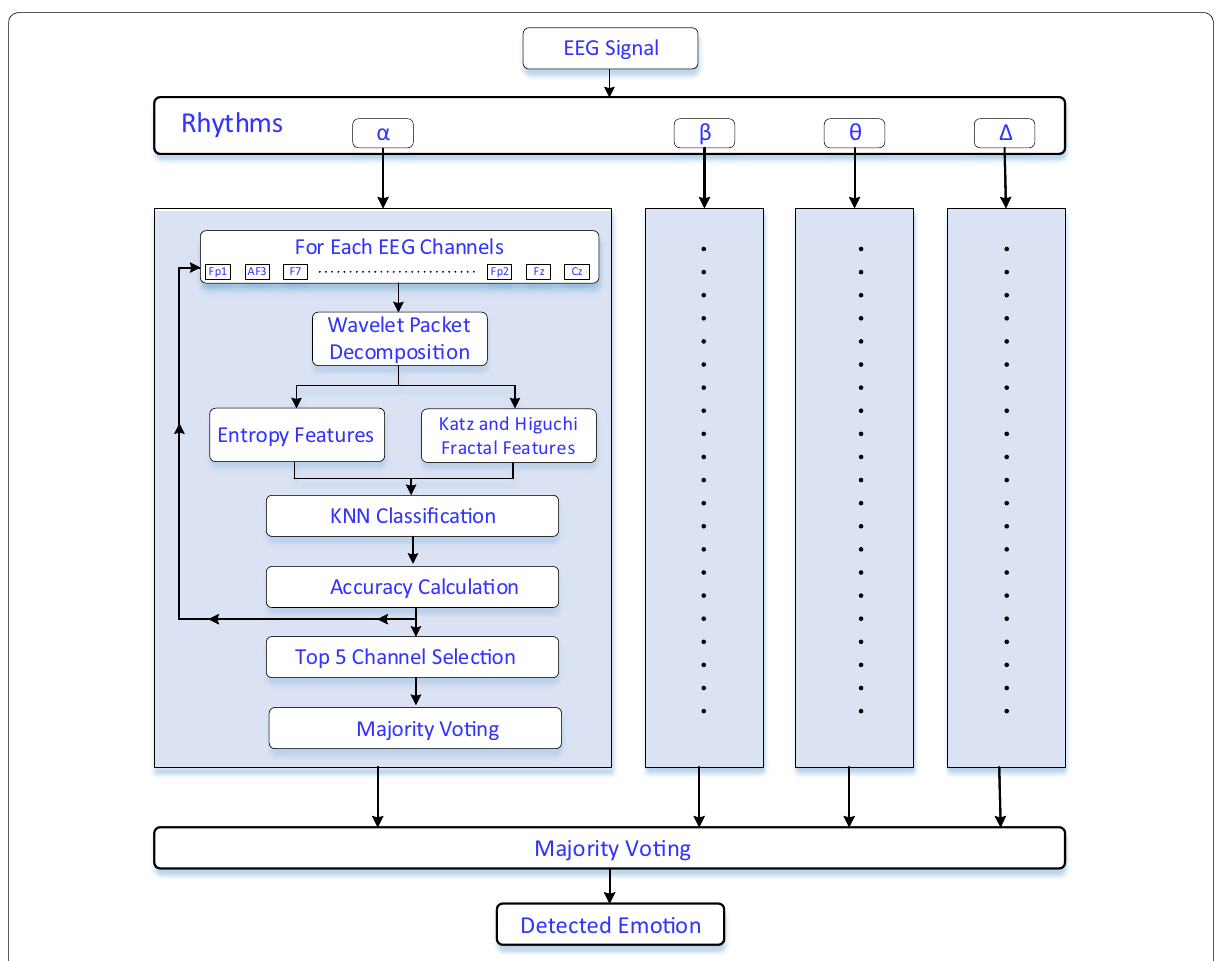
Fig. 1 The graphical illustration of the proposed